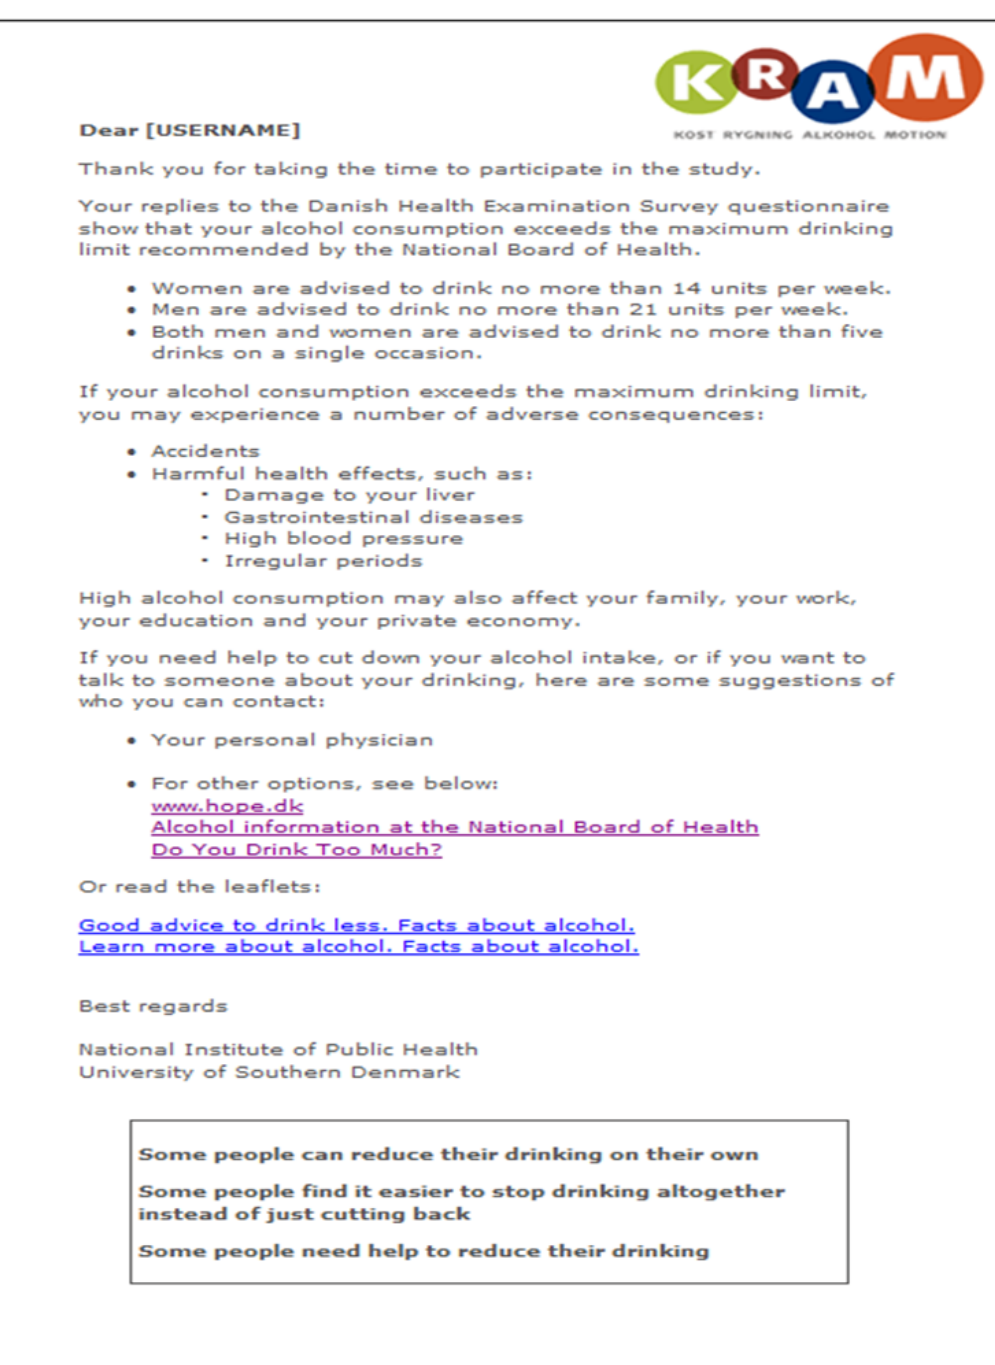
Figure 2. Screenshot of the Internet-based personalized brief advice